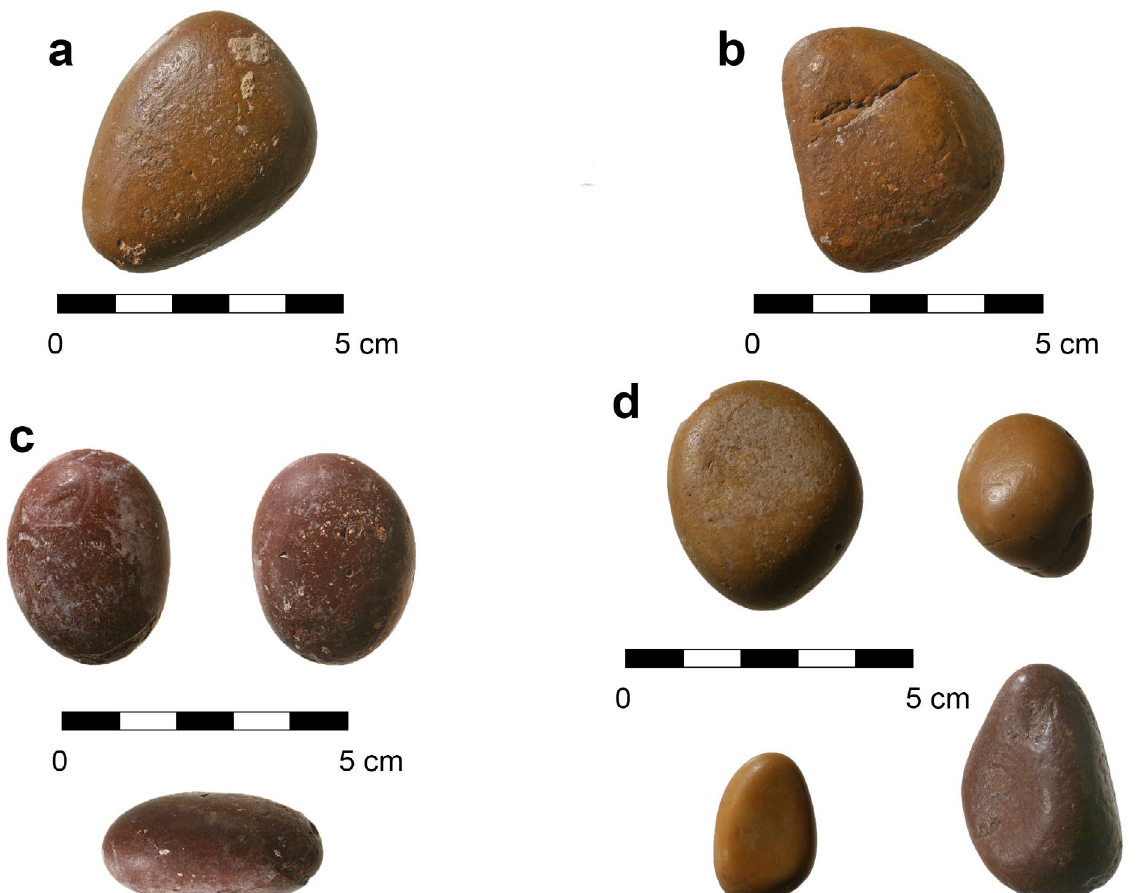
Figure 4. ( a-c ): Flint pebbles originating from the archaeological layers of the cave. (d) Flint pebbles that were found at the stream channel 1.1-5 km east of the